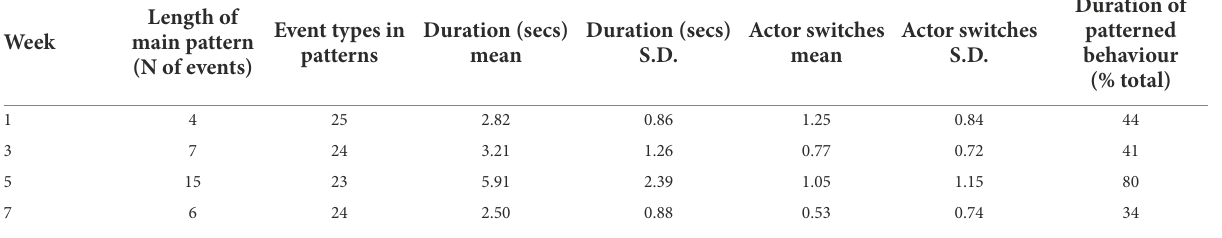
TABLE 3 Group 1: Summary of pattern data by